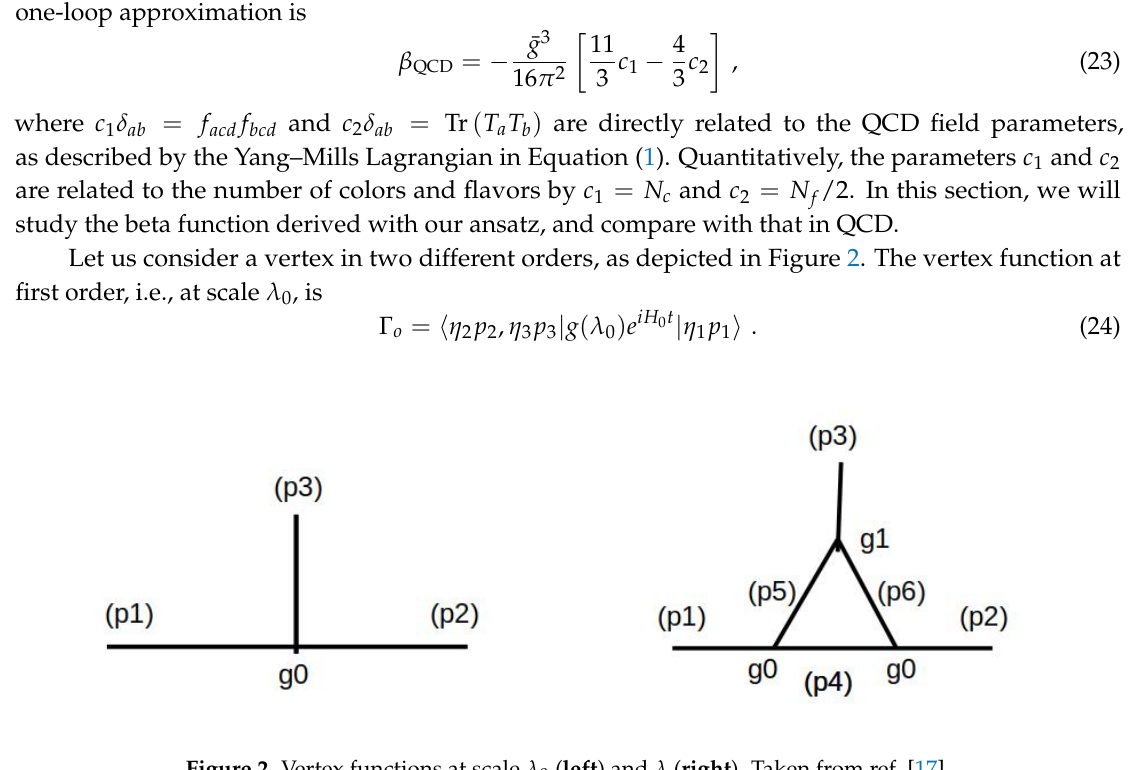
Figure 2. Vertex functions at scale λ 0 ( left ) and λ ( right ). Taken from ref.